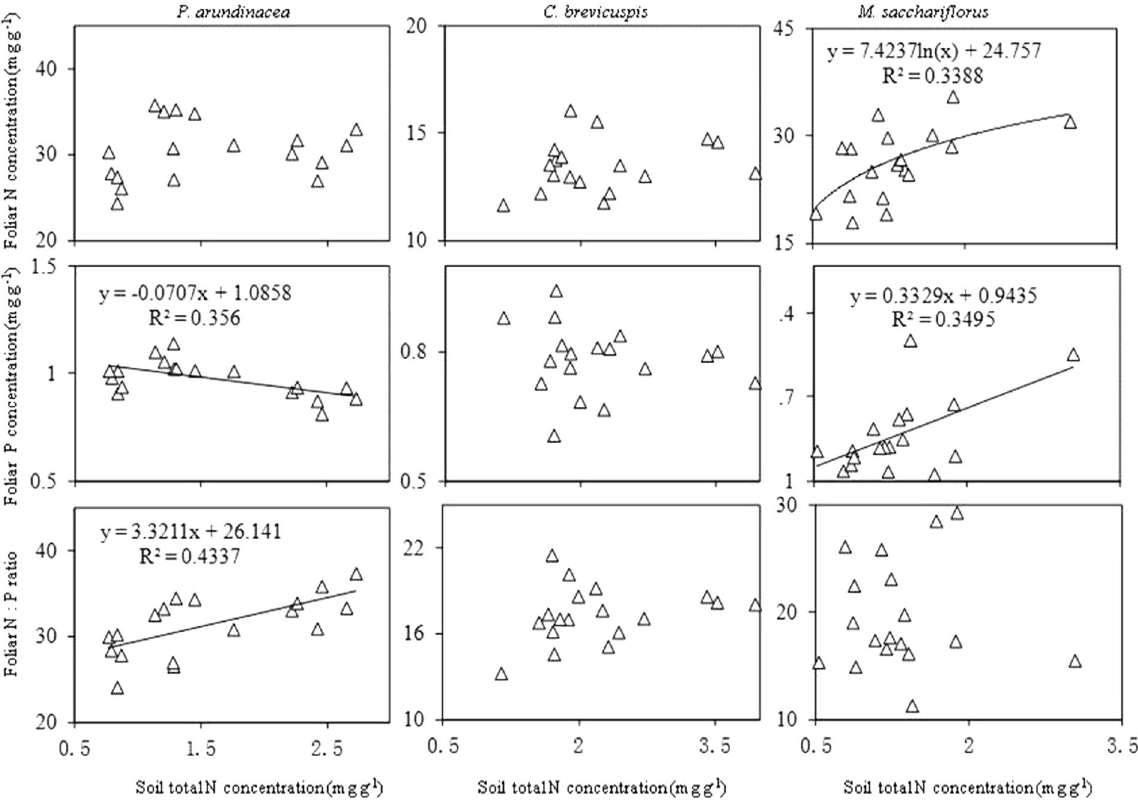
Figure 6. Relationship of foliar stoichiometric indexes with soil total nitrogen (N) of the 3 wetland species distributed along an elevation gradient in 3 lakeshore areas of Dongting Lake,